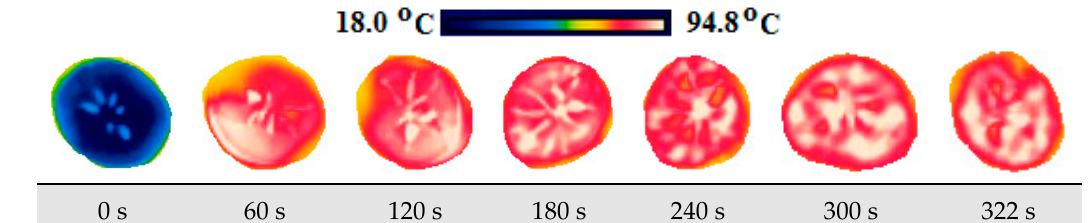
Figure 11. Thermal images of persimmon with 5 mm at 350 W.